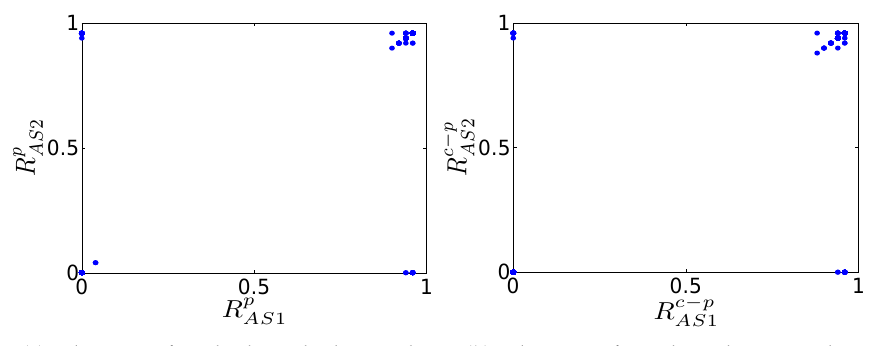
Figure 4. Robustness under simultaneous attack and sequential attack. Each point is the robustness under simultaneous attack and sequential attack with the same target set. AS 2 represents the sequential attack and AS 1 represents the simultaneous attack. Figure 4a shows the robustness of a single physical network under different attack sequences; Figure 4b shows the robustness of interdependent Cyber-Physical network under different attack